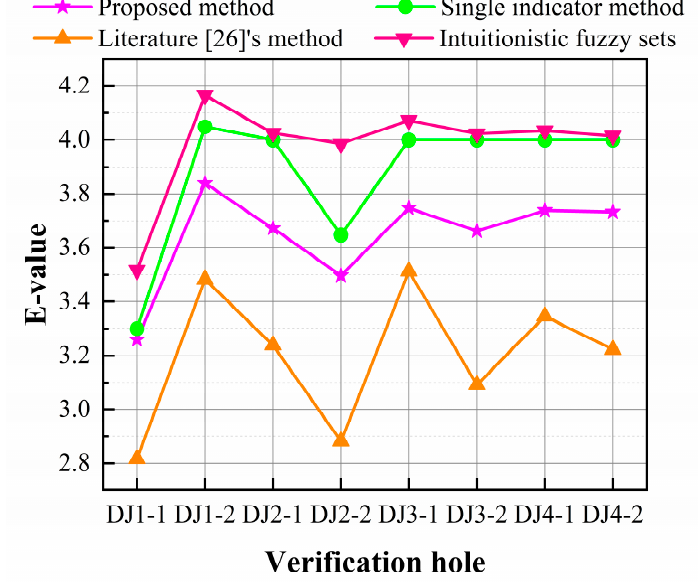
Figure 16. Comparison of the evaluation results by the proposed method, original evaluation methods, and the intuitionistic fuzzy